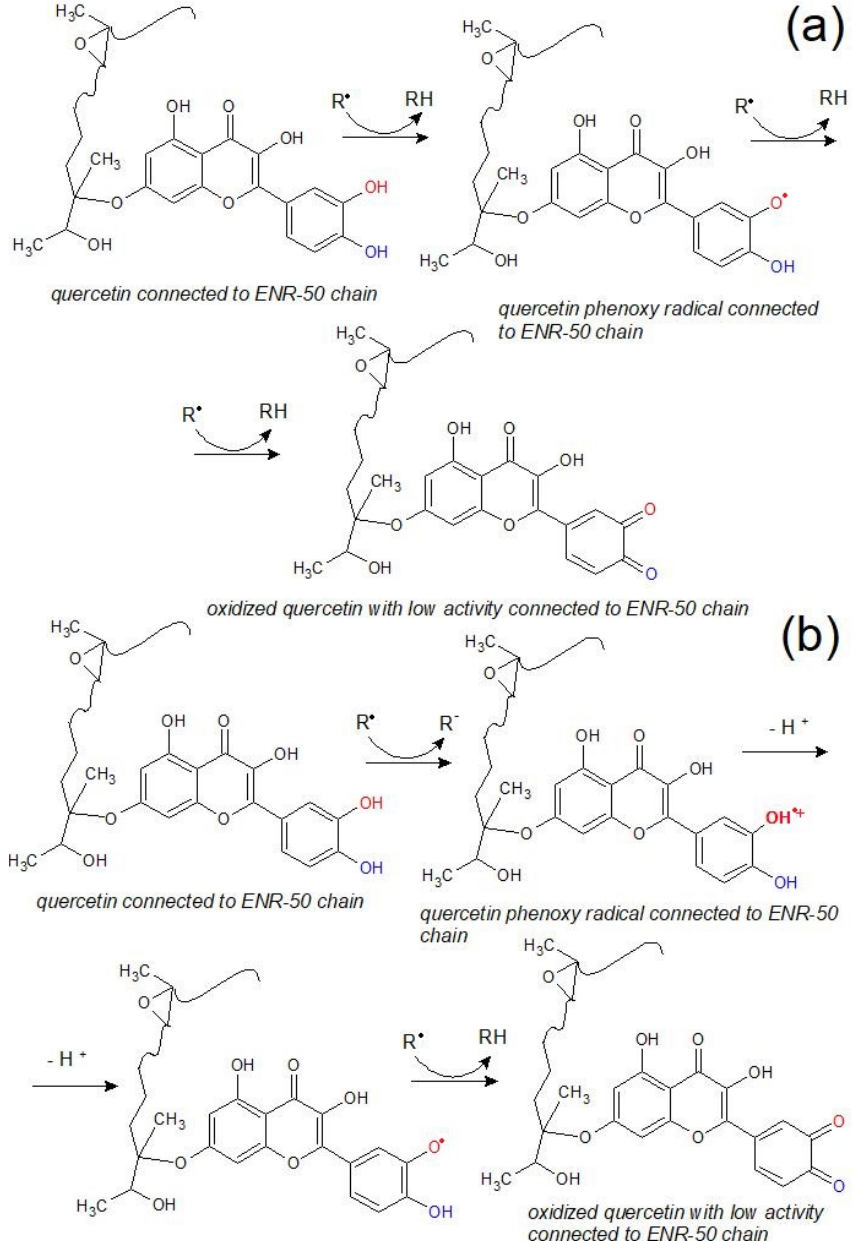
Figure 10. Proposed mechanisms for free radical scavenging activity of quercetin connected to ENR ‐ 50 chain. Hydrogen atom donation ( a ) and electron transfer ‐ proton transfer ( b ).